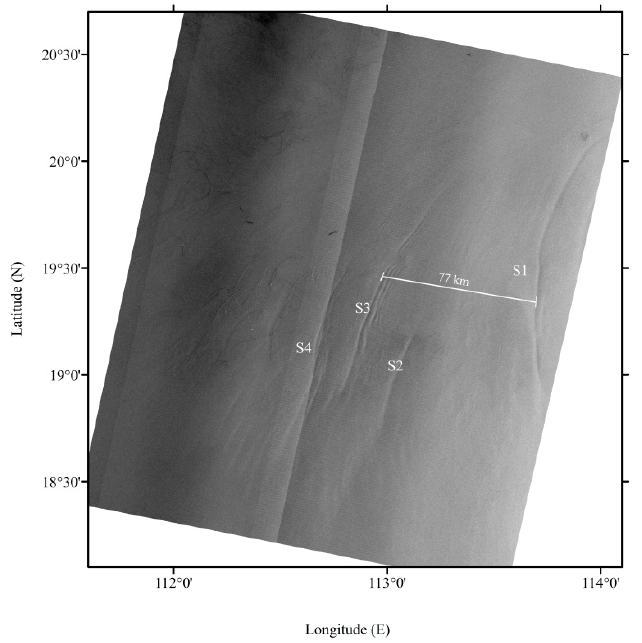
Figure 7. An Envisat ASAR image acquired at 02:28:22 UTC on 6 November 2005.